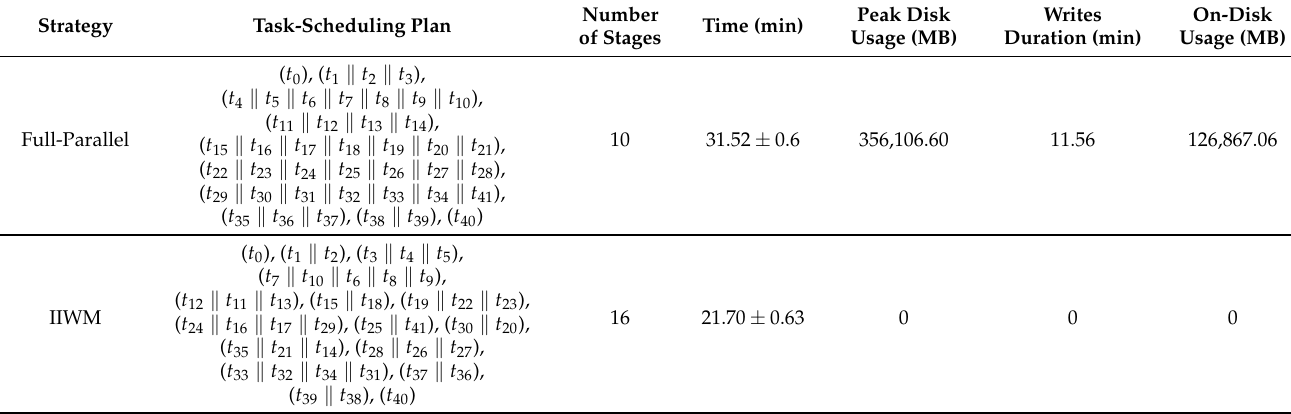
Table 9. Scheduling plan and statistics about execution times and disk usage with 14 GB of RAM. Strategy Task-Scheduling Plan